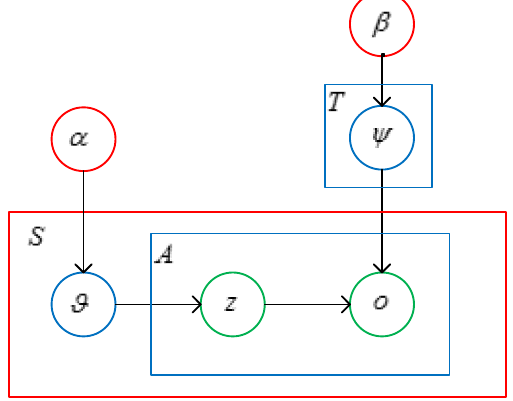
Figure 3. Implication of the LDA model.